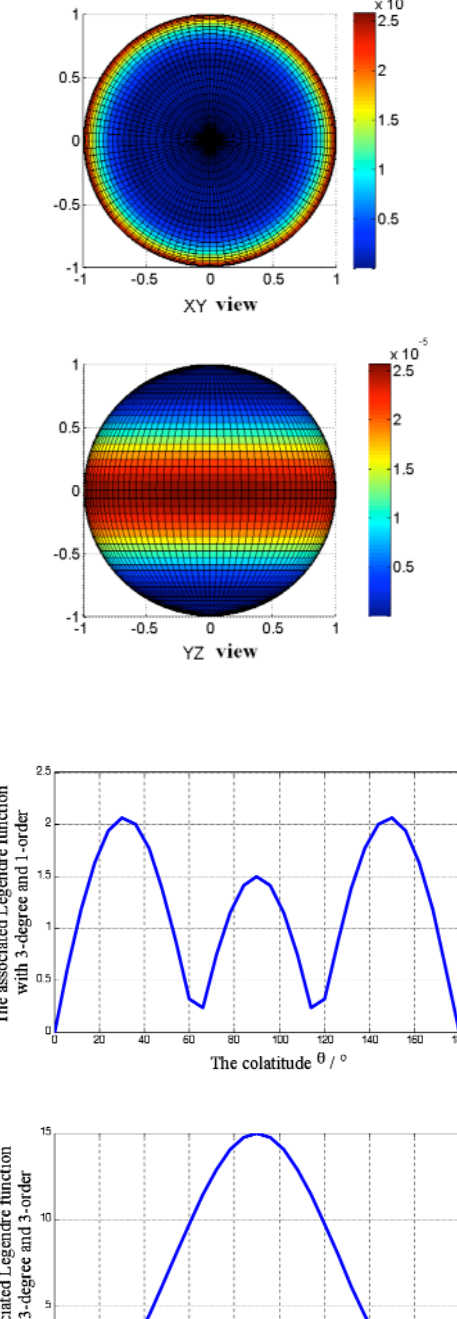
(cos i ), P (cos i ), P (cos i ) and P 30 31 32